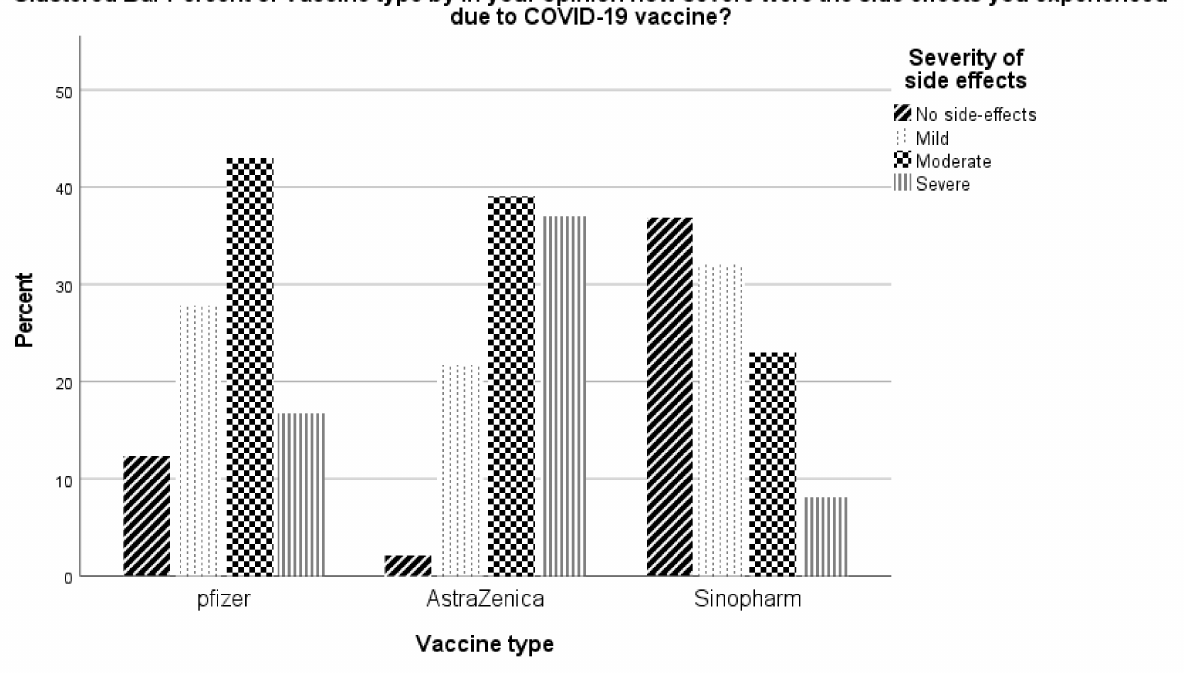
Figure 1. Severity of the side effects by vaccine